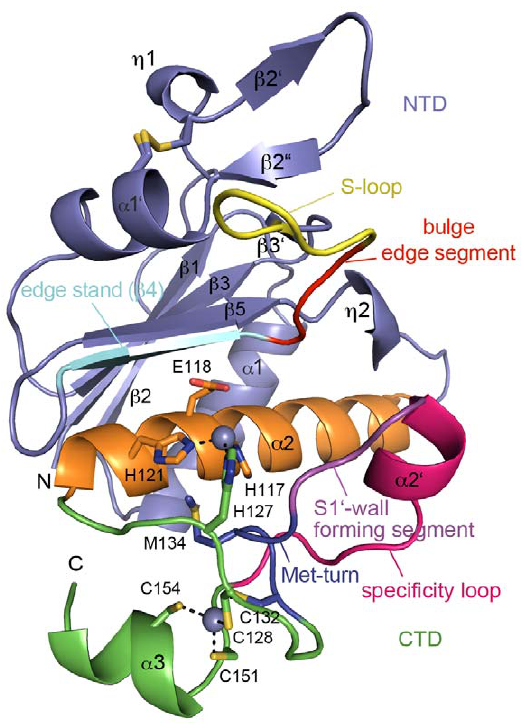
Figure 1. Structure of Af AmzA. Overall structure of Af AmzA in cartoon representation. The N-terminal domain (NTD) is colored in slate, the active site helix a 2 in orange and the C-terminal domain (CTD) in green. The N- and C-termini, the edge strand b 4 (cyan), the backing helix a 1, the S-loop (yellow), the bulge edge segment (red), the S1 9 -wall forming segment (magenta) and the specificity loop (purple) are labeled. The residues involved in zinc ion binding, the catalytic base and the structurally important methionine are shown as sticks and the zinc ions as spheres.